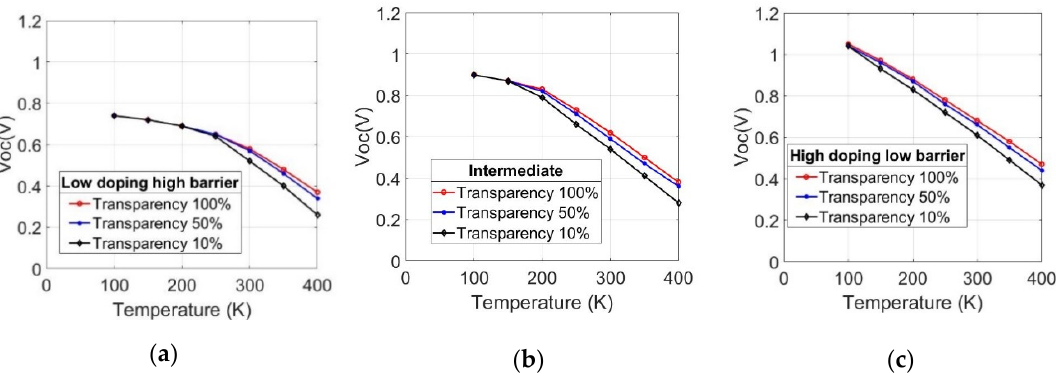
Figure 7. Voc against temperature plot for ( a ) the low-doping high-barrier case, ( b ) the intermediate case, and ( c ) the high-doping low-barrier case with transparency values of 100, 50 and 10%.